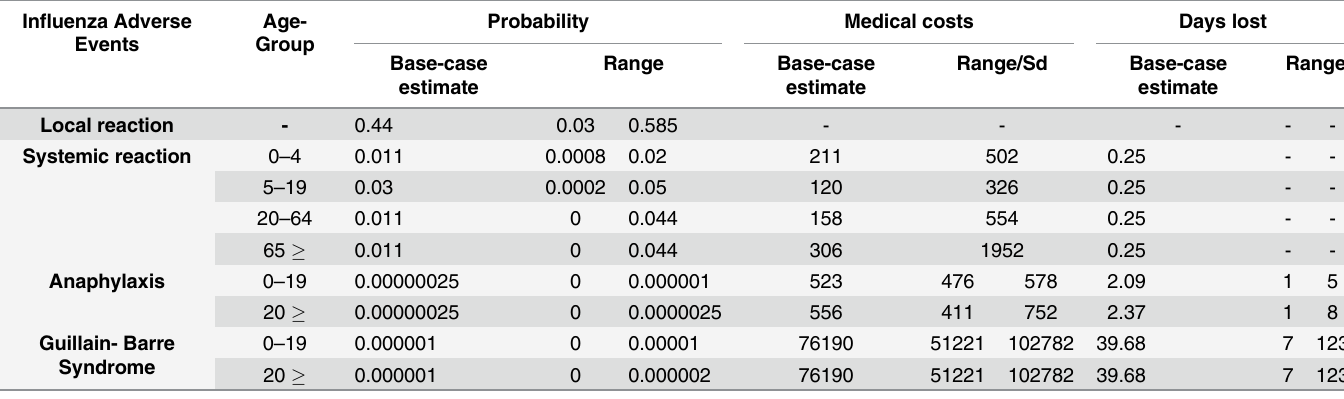
Table 3. Probability and cost of influenza vaccine adverse